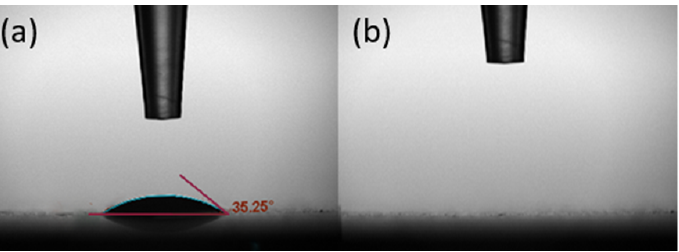
Figure 3. Static water contact angles of ACMs at 0 s ( a ) and 2 s ( b ) under air. Pure water flux of selected ACMs was measured under different trans-membrane pressures. The results are shown in Figure 4. Good linear relationships were found be- tween the pure water flux and the trans-membrane pressure, and attractive pure water permeability values of 6129 L·m −2 ·h −1 ·bar −1 were obtained from the slopes in Figure 4. The above results showed that the ceramic membranes had a good pure water permeability.